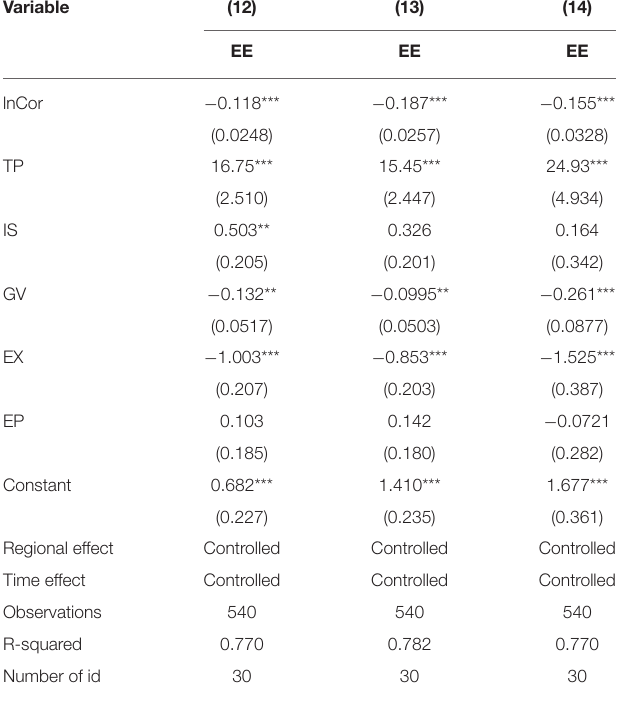
TABLE 11 | Robustness